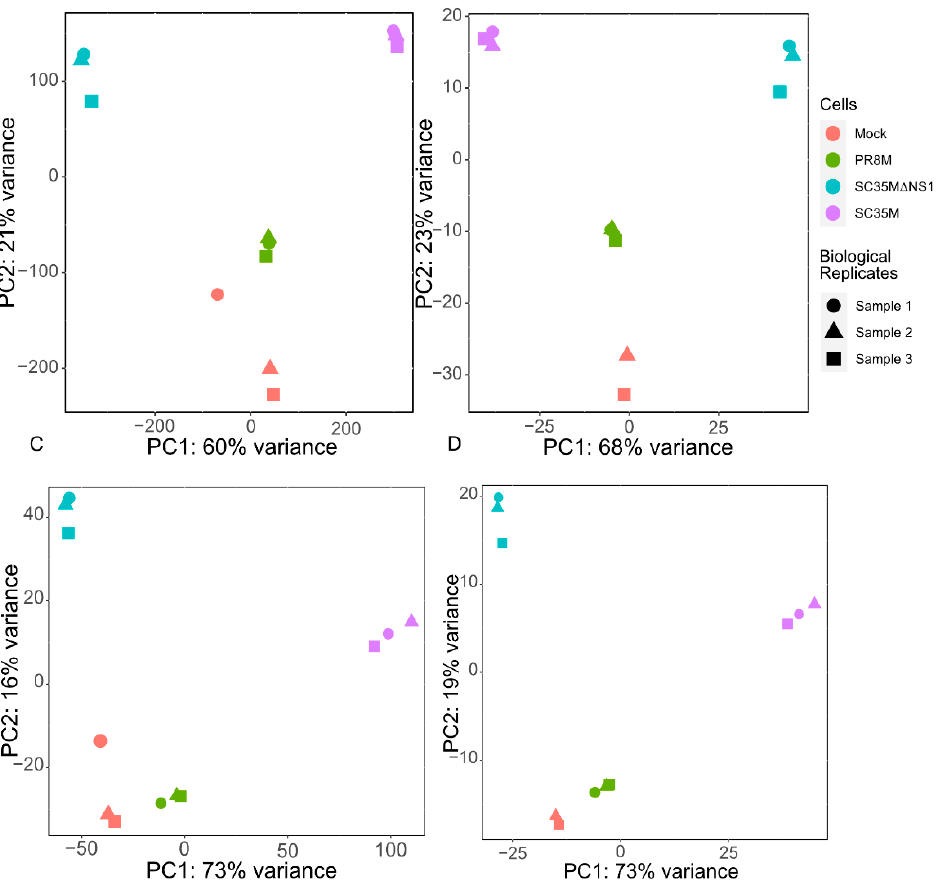
Figure A1. Principal component analysis (PCA) plots of the gene matrix ( A , B ) and HERV loci matrix ( C , D ) of second technical replicates. ( A , C ) PCA plots with all samples included. ( B , D ) PCA plots with the control sample 1 removed.